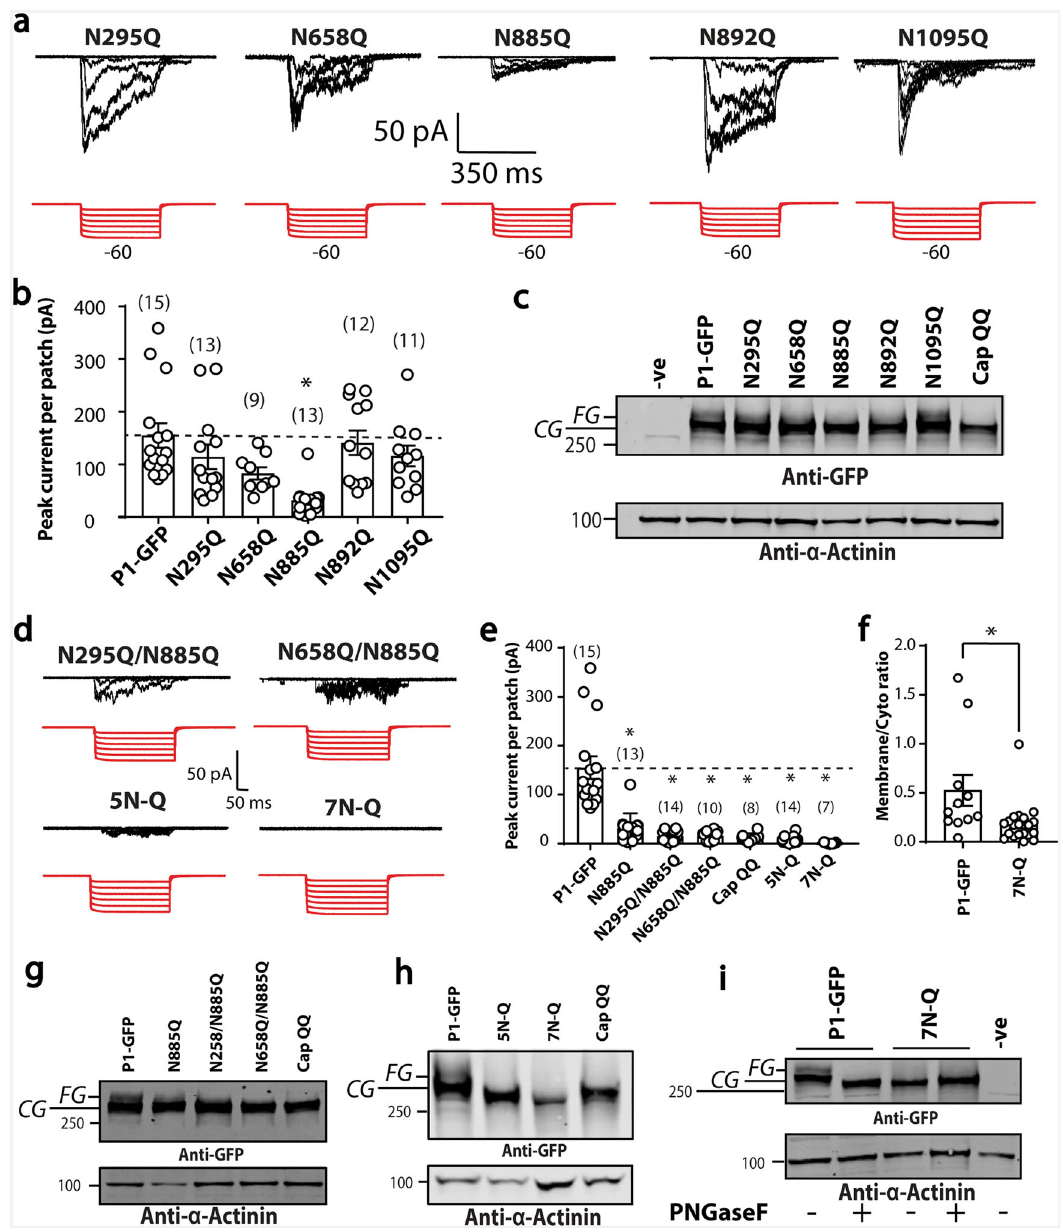
Fig. 6 N-glycosylation in the N-terminus of Piezo1. a Electrophysiological recordings of Piezo1 − / − HEK293T expressing single Asn to Gln Piezo1-GFP mutations in the N-terminus (N295Q, N658Q, N885Q, N892Q, N1095Q) in the cell-attached con fi guration in response to negative pressure applied using a high-speed pressure-clamp (red). b Quanti fi cation of peak current elicited per patch for point mutations shown in a compared to current from Piezo1- GFP. c Representative western blot of all Asn to Gln mutants in the N-terminus of Piezo1 compared to the double mutant in the Cap region (CapQQ). d Electrophysiological recordings of HEK293T Piezo1 − / − expressing Piezo1 with multiple Asn to Gln mutations (as indicated) in the cell-attached con fi guration in response to negative pressure applied using a high-speed pressure-clamp (red). [5N-Q — N295Q, N658Q, N885Q, N892Q, N1095Q and 7N-Q — N295Q, N658Q, N885Q, N892Q, N1095Q, N2294Q, N2331Q]. e Quanti fi cation of peak current elicited per patch for mutation combinations shown in d compared to current from Piezo1-GFP, N885Q and CapQQ. f Membrane to cytoplasmic ratio of immunogold labelling of the 7N-Q mutation compared to human Piezo1. g Representative western blot showing the comparison between Asn to Gln mutations of single and double mutations illustrating the strong impact of N885Q mutation on the upper FG band of Piezo1 heterologously expressed in Piezo1 − / − HEK293T. h Representative blot showing the comparison between multiple Asn to Gln mutations 5N-Q, 7N-Q and the CapQQ (N2294Q/N2331Q). i Representative blot showing the comparison between PNGaseF digested WT and the 7N-Q mutant. * p < 0.05 determined by Kruskal – Wallis test with Dunn ’ s post-hoc test or Mann – Whitney U -test. − ve represents an un-transfected